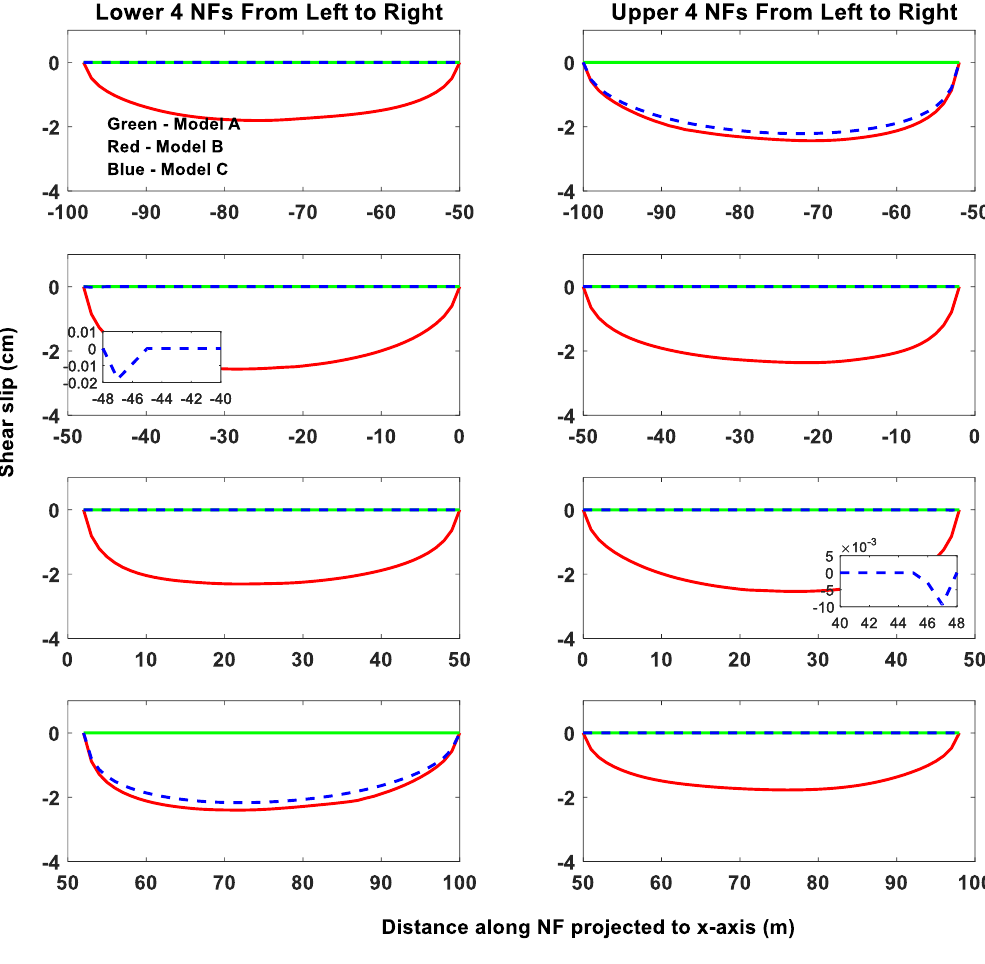
Figure 2—Activation of the NFs in the Models A, B and